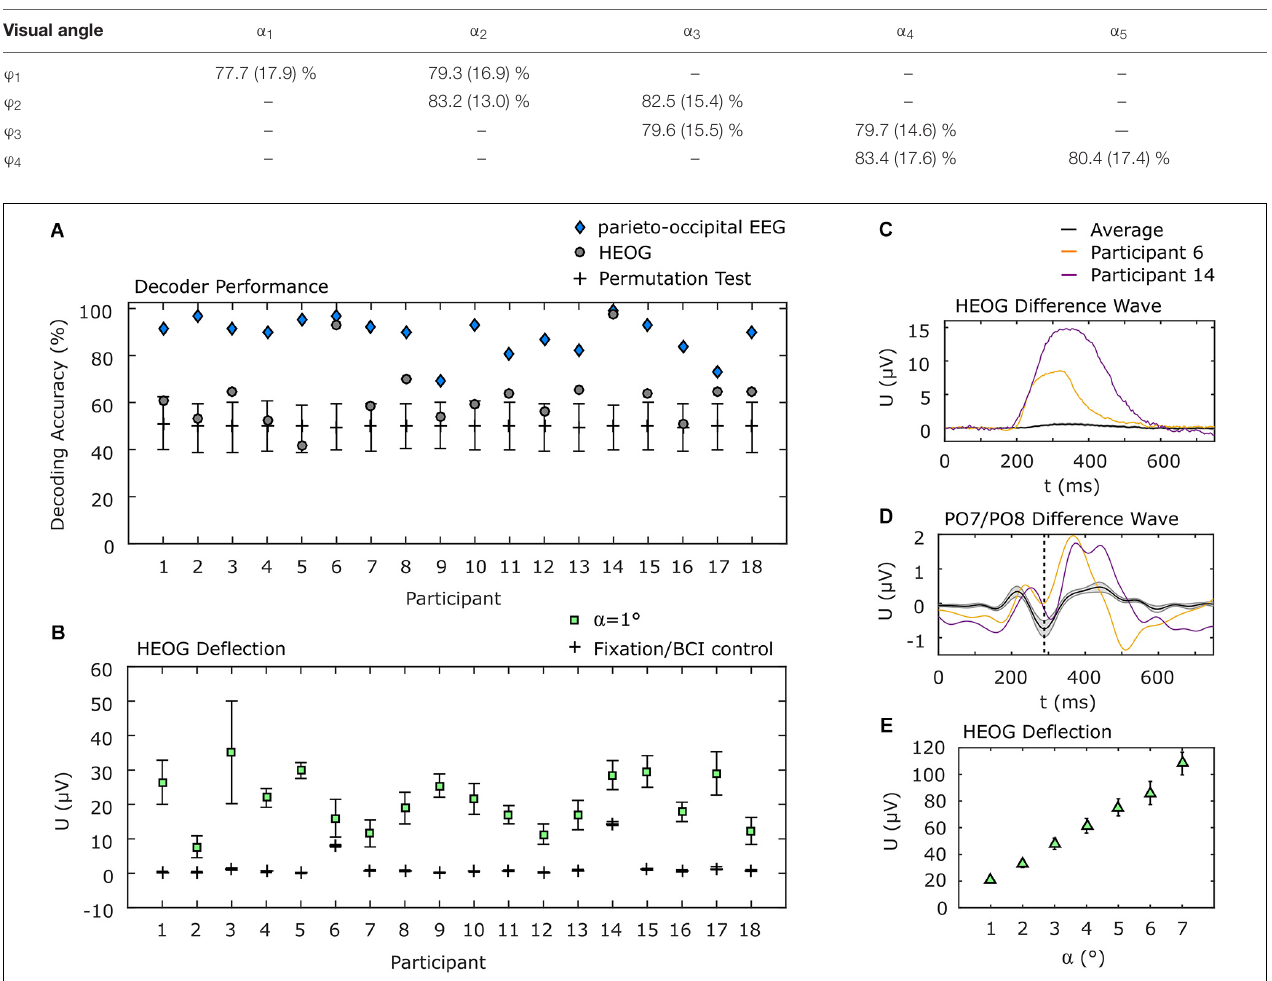
TABLE 1 | Decoding accuracy achieved with single parameter pairs (standard deviation in parenthesis).